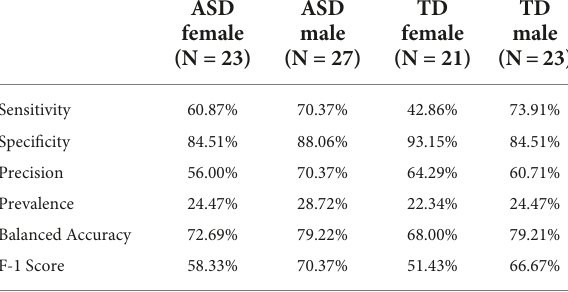
TABLE 3 Individual class statistics from the linear discriminant